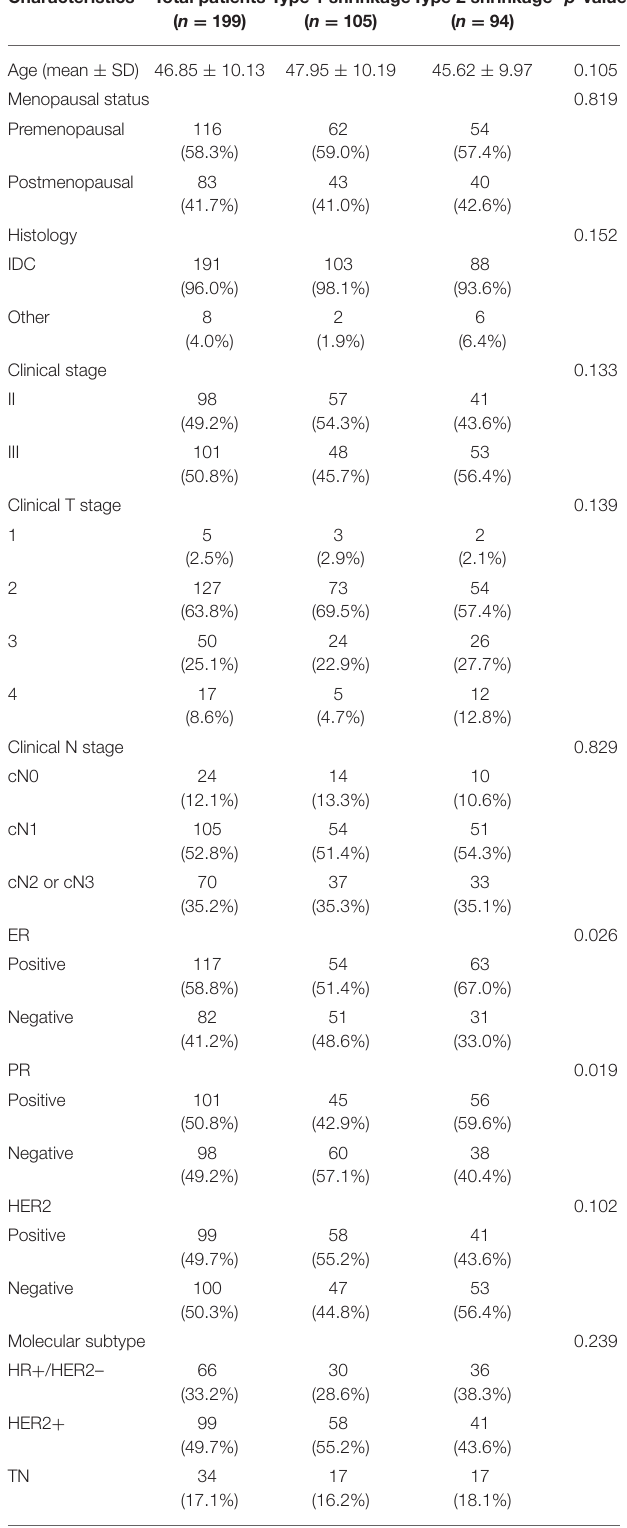
TABLE 1 | Clinical and histopathological characteristics of study population grouped by tumor shrinkage